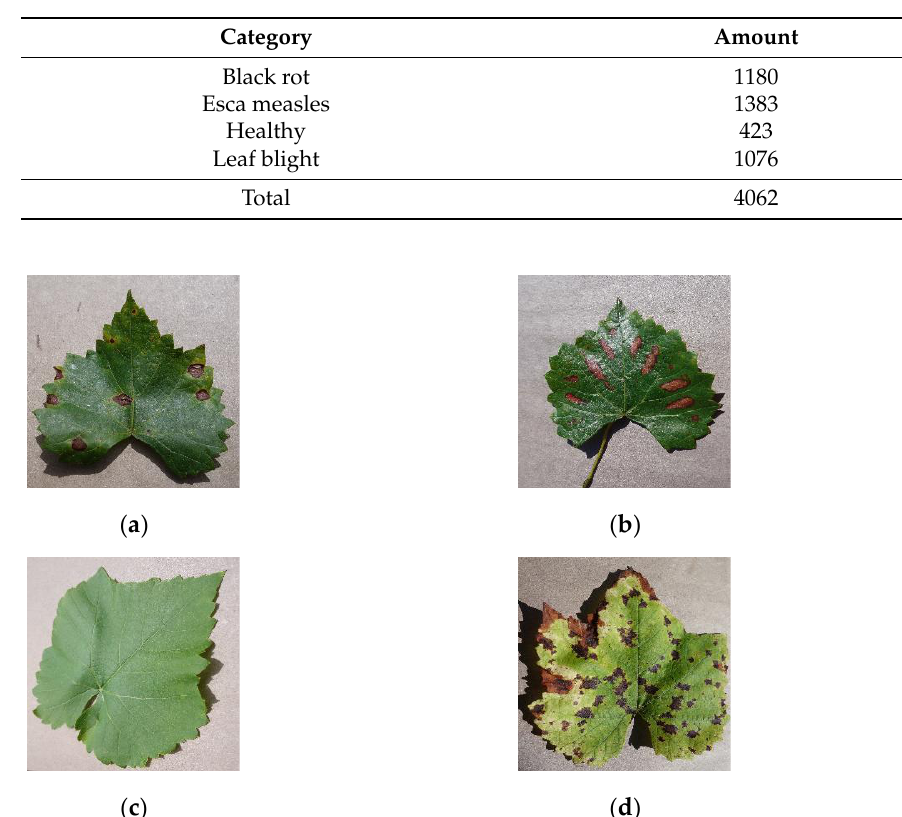
Table 1. Grape leaf disease dataset.